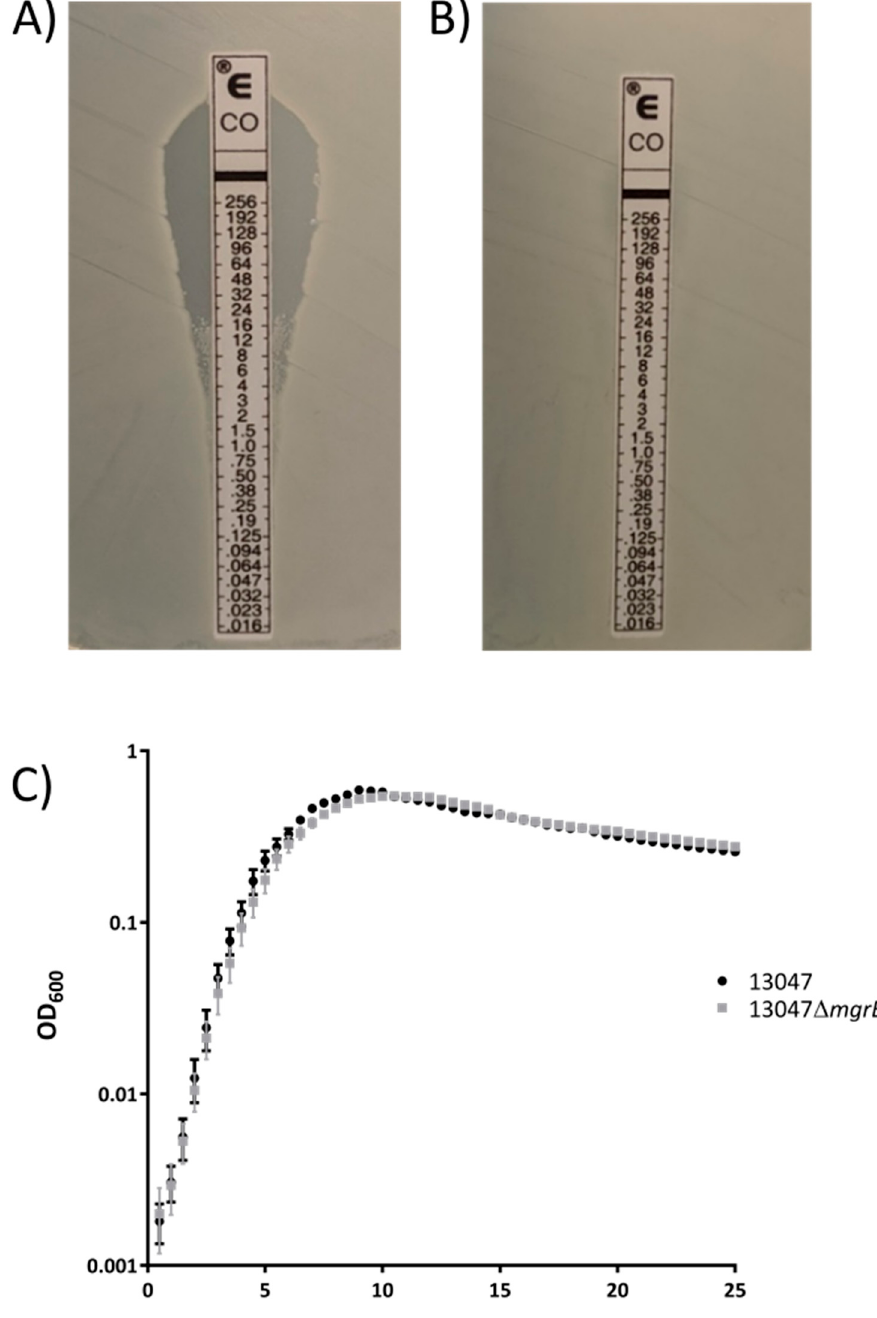
Figure 2. Deletion of mgrB causes high-level colistin resistance in the absence of a growth delay. ( A ) Etest of ATCC13047. ( B ) Etest of ATCC13047 Δ mgrB. ( C ) Growth curve of ATCC13047 and ATCC13047 Δ mgrB. Growth curves were performed in Mueller–Hinton broth.